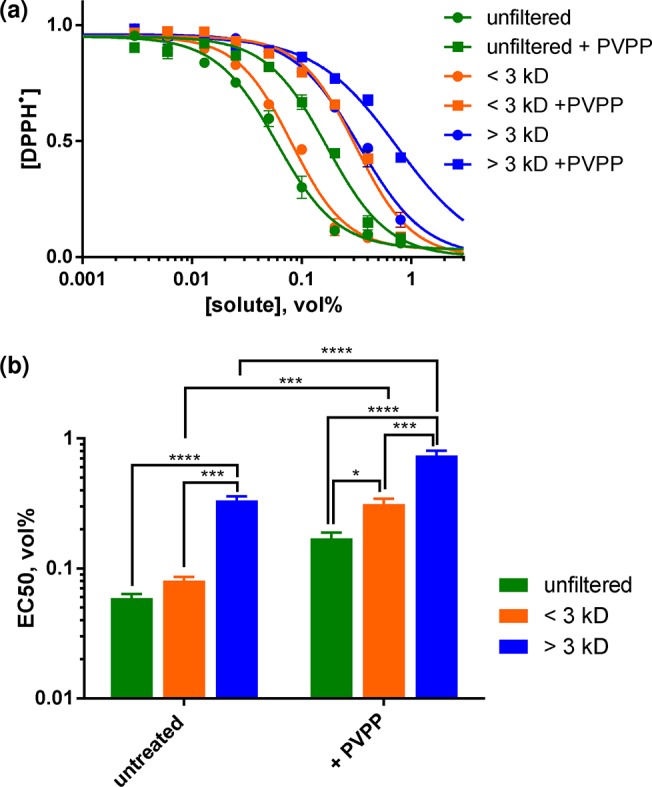
Reduction of DPPH• to its hydrazine form DPPH-H in the presence of brewed coffee.(a) Dose response curves; (b) EC50 values calculated from the curves. The brew was optionally pre-treated with PVPP, followed by filtration through a 3 kD MWCO membrane. Reactions contained MeOH/water (1:1) solutions of 50 μM DPPH and varying dilutions of coffee brew. Significant differences were calculated by two-way ANOVA using the Holm-Šídák multiple comparison test (n = 3): ****P < 0.0001, ***P < 0.001, **P < 0.01, *P < 0.05. Numerical EC50 data is provided in S1 Table.